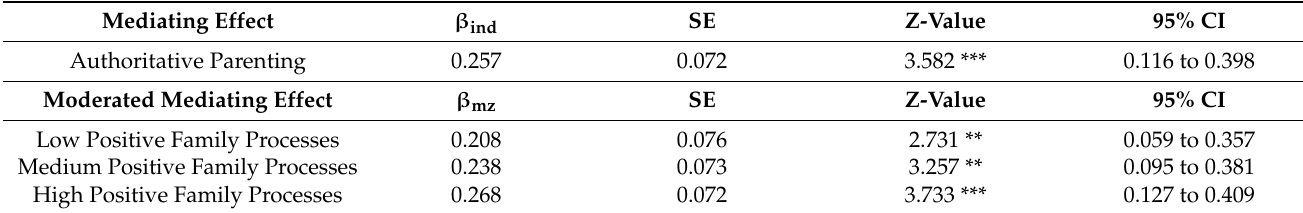
Figure 1. Structural Relationships of Positive Family Processes and Authoritative Parenting in Prediction of Psychosocial Maturity of Chinese Youths (Model 1). Note: Model fit is CFI = 0.982, RMSEA = 0.050, X 2 = 126.204, df = 54, X 2 /df = 2.337, AIC = 9493.674, and BIC c = 9533.358. * p < 0.05; ** p < 0.01; *** p < 0.001. Table 3. Mediation of Authoritative Parenting and Moderated Mediation by Positive Family Processes and Authoritative Parenting in Prediction of Chinese Youths’ Psychosocial Maturity.